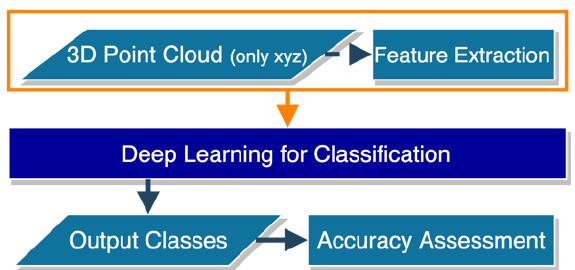
Figure 6. The used deep learning classification approach.